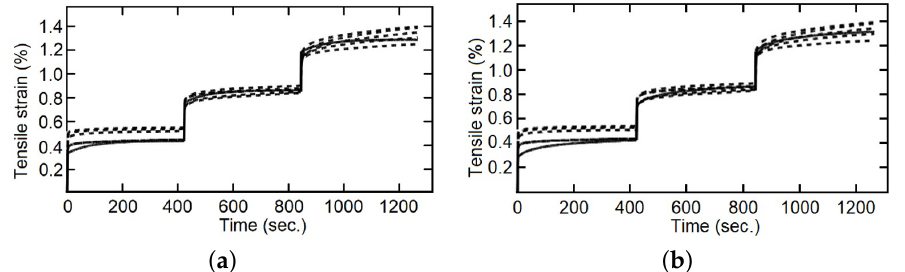
Figure 13. Tensile strain for staggered fluency test, five specimens with 28 wt%, experimental data in dotted lines and model response in continuous line, ( a ) integer index model, ( b ) fractional index